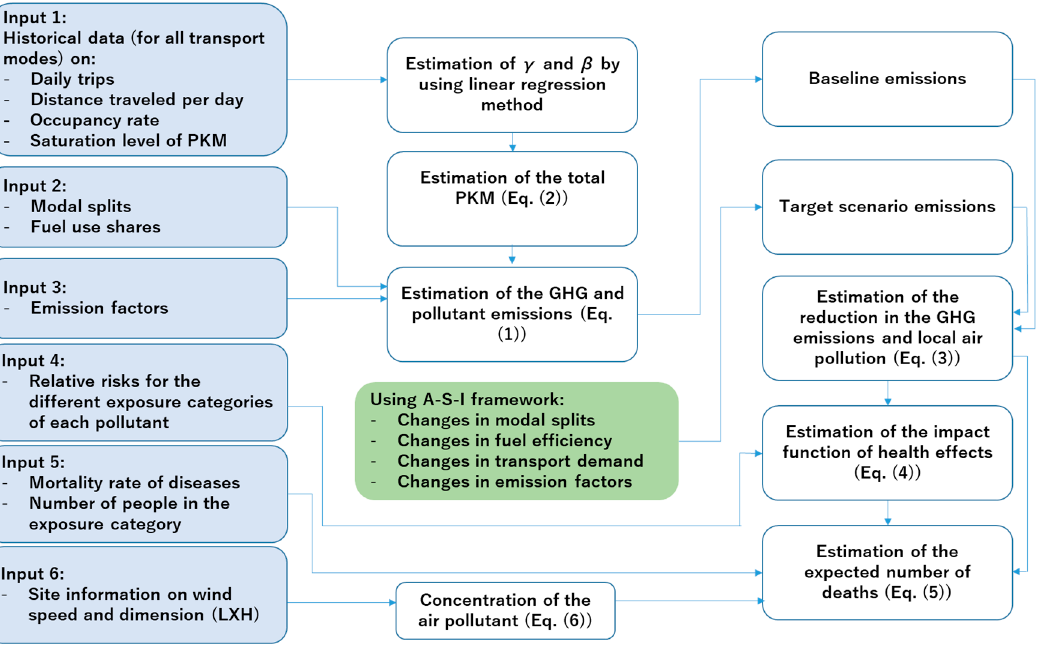
Figure 2. The calculation steps in the model.